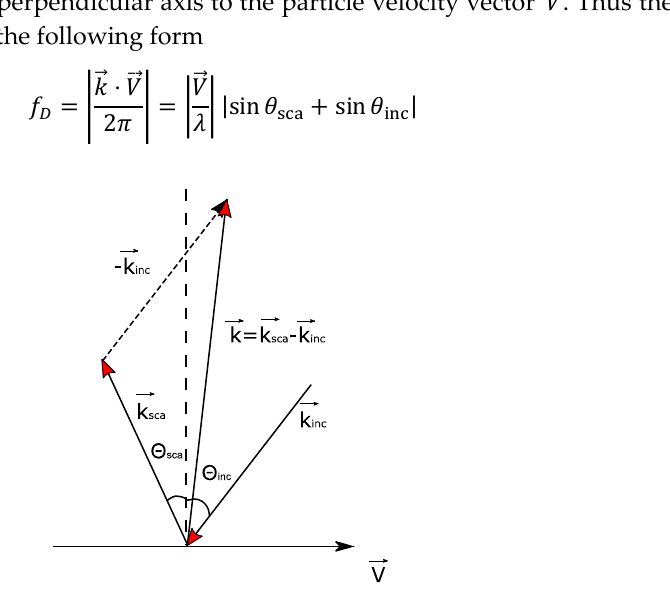
Figure 1. The schematic of the incident and scattered light